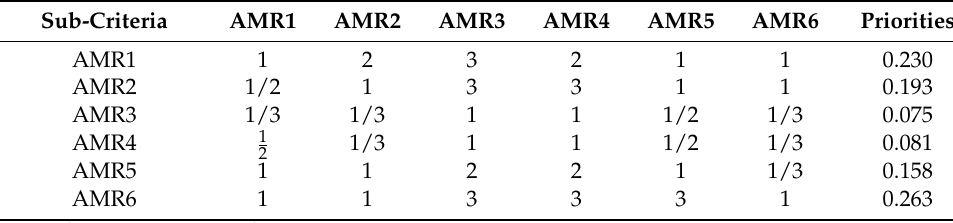
Table 4. Pairwise comparison matrix for the sub-criteria with respect to AMR. Sub-Criteria